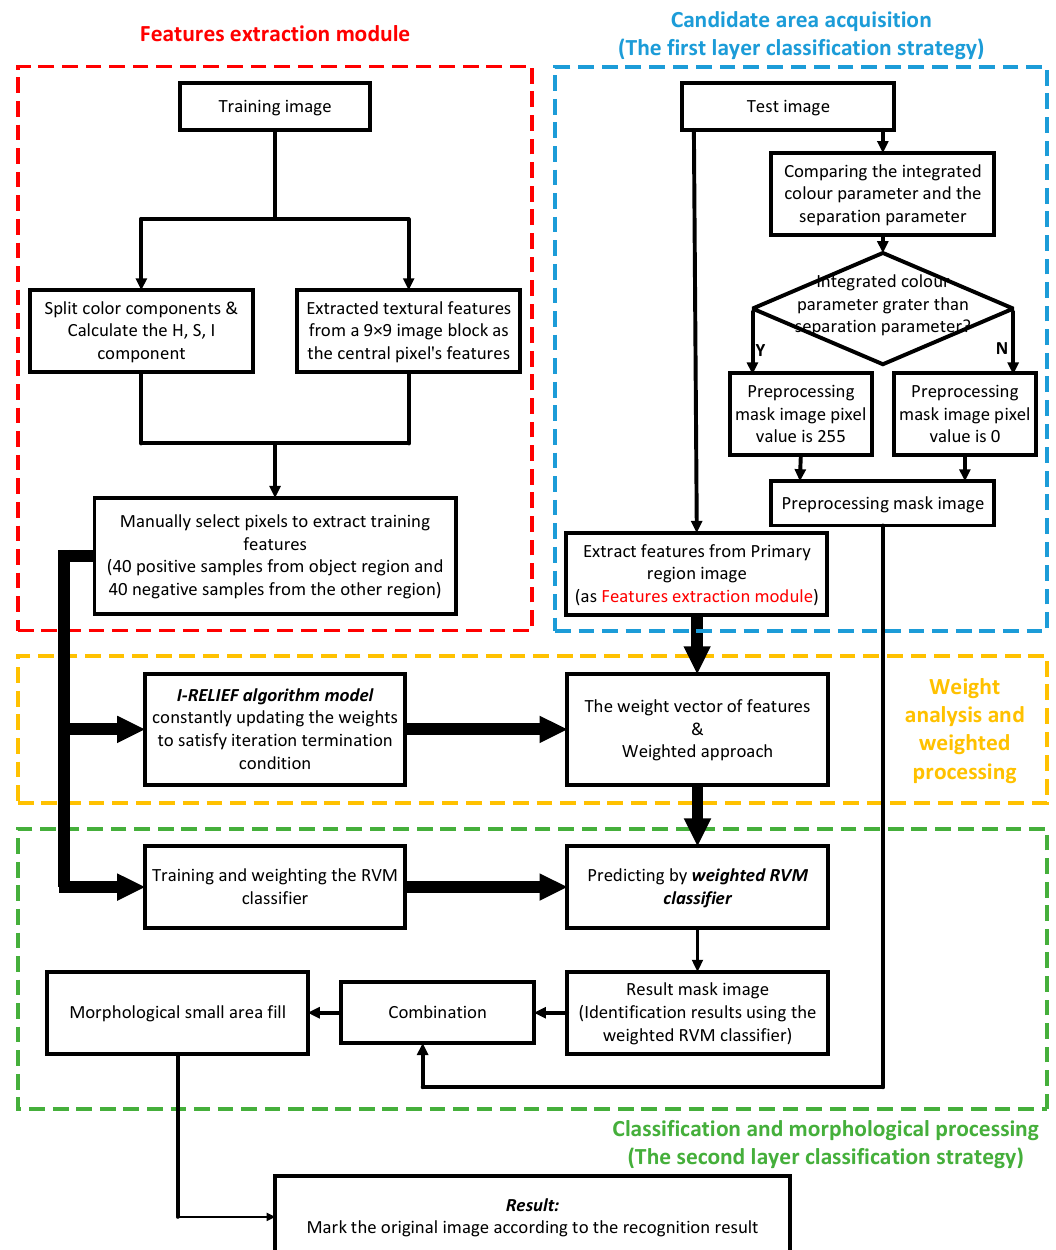
Figure 1. Flowchart of the algorithm for automatic recognition of ripening tomatoes.